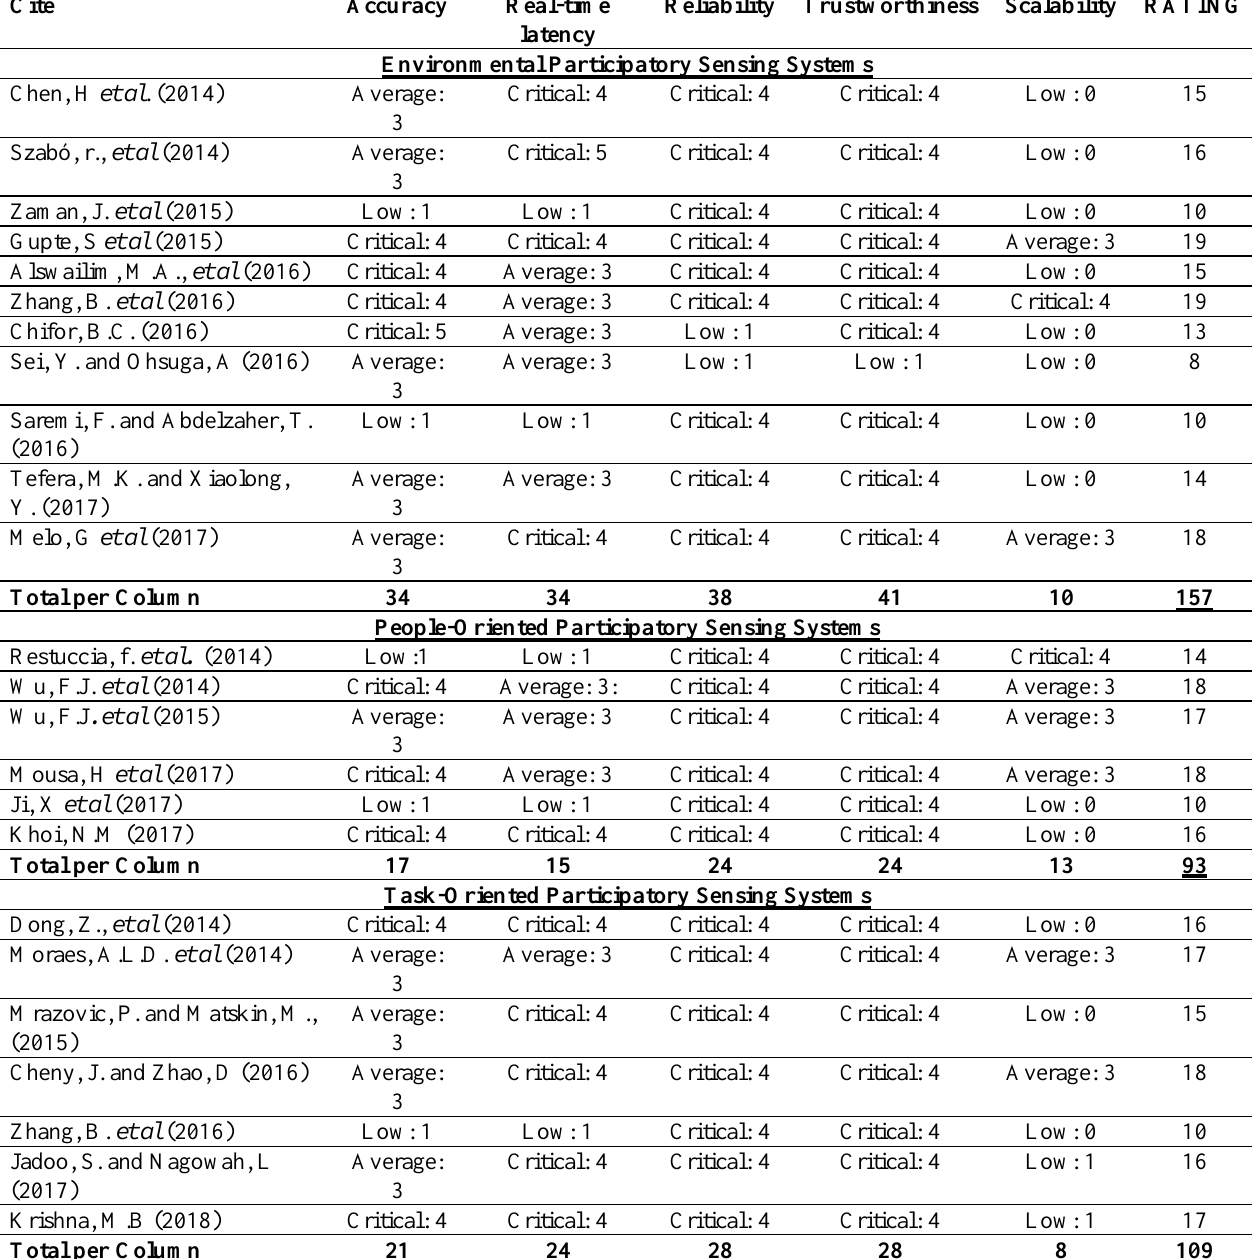
Table 5. Evaluating the Participatory Sensing